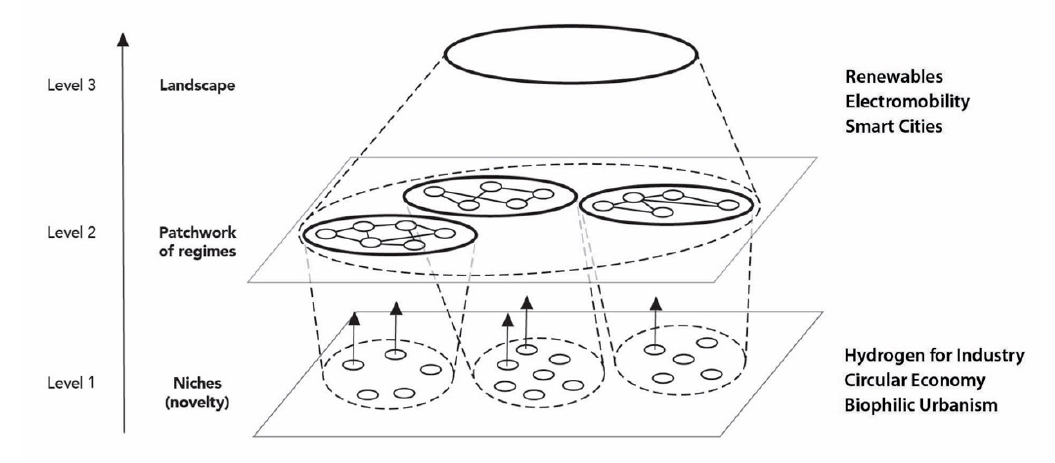
Figure 3. Multilevel perspectives on innovations. Source: Redrawn from Geels et al.